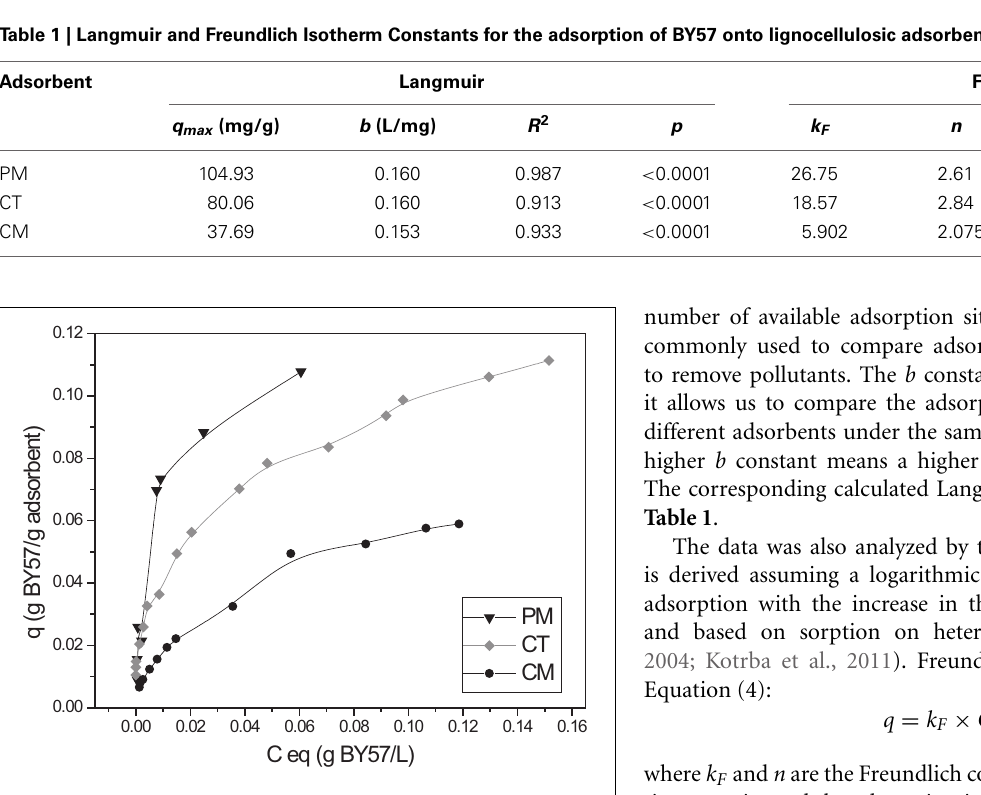
FIGURE 7 | Adsorption Isotherm of the adsorption of BY57 onto tea